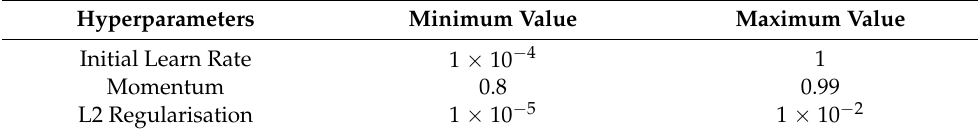
Table 1. Hyperparameters and their ranges of improved ResNet 50.